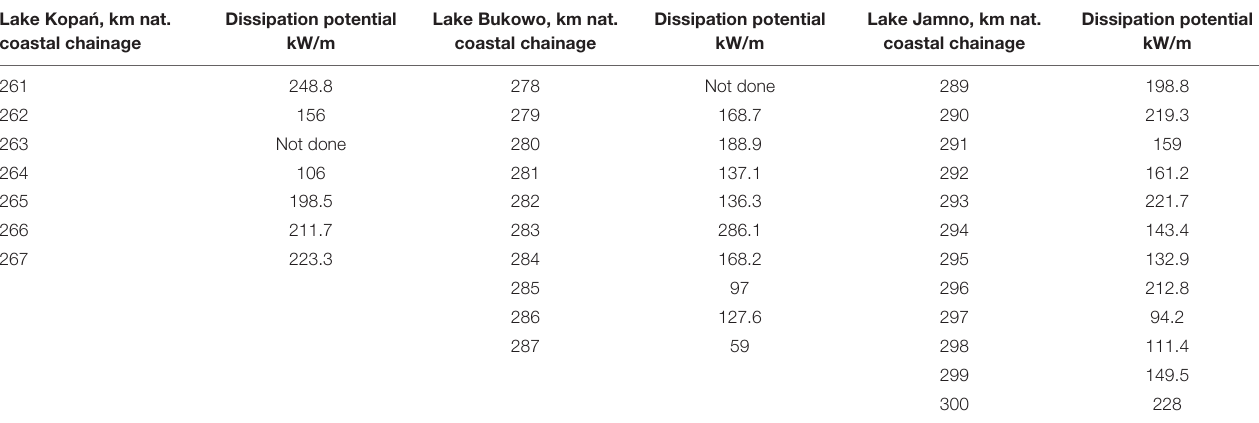
TABLE 4 | Wave energy dissipation for seabed survey of 2005-6 using monotonic seabed concept. Lake Kopa´n, km nat. coastal